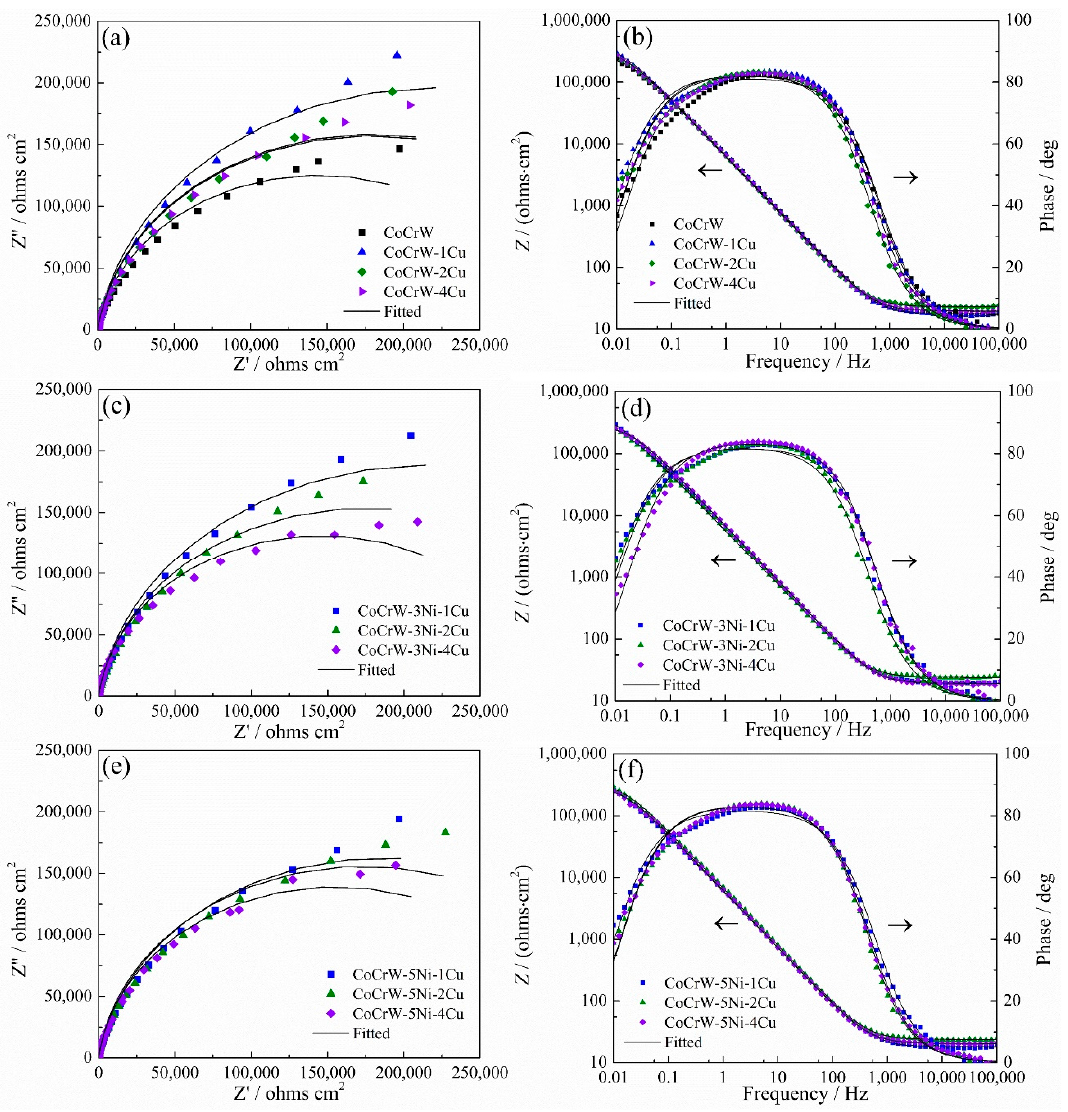
Figure 6. ( a , c , e ) Nyquist plot diagram, ( b , d , f ) Bode and Bode phase plot diagram of the as-cast CoCrW-xNi-yCu alloys: ( a , b ) CoCrW-yCu, ( c , d ) CoCrW-3Ni-yCu and, ( e , f ) CoCrW-5Ni-yCu alloys.